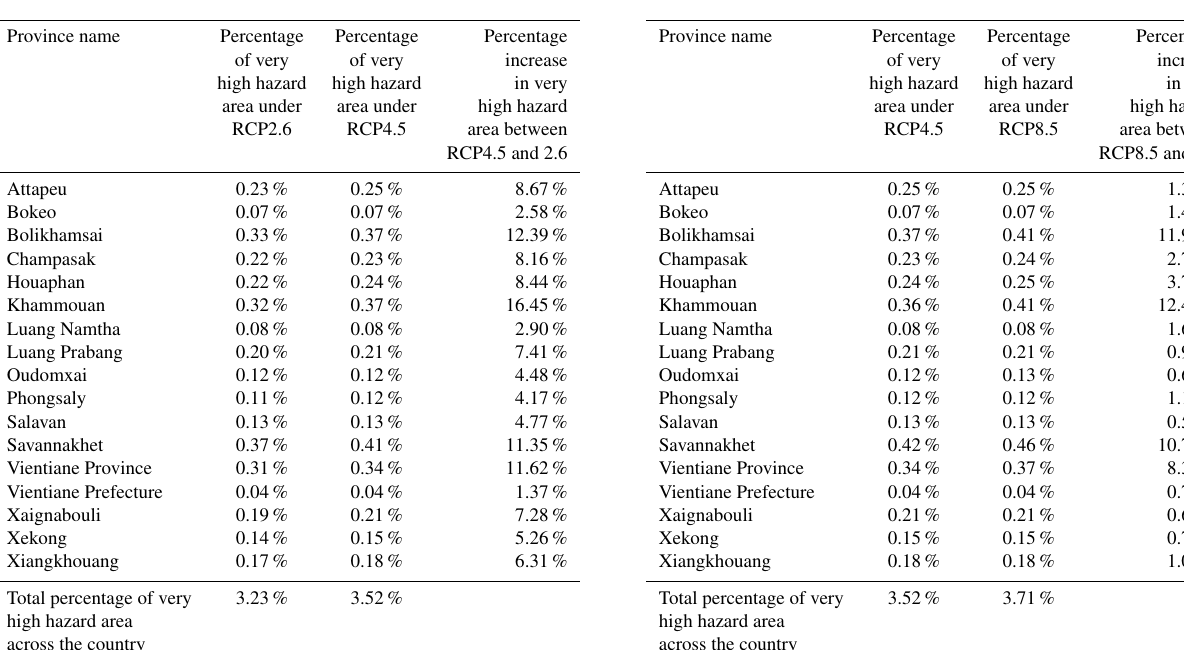
Table 4. Percentage of very high hazard area from the integrated hazard map in each province and the percentage of increase between the RCP4.5 and RCP2.6 scenarios during the far future.